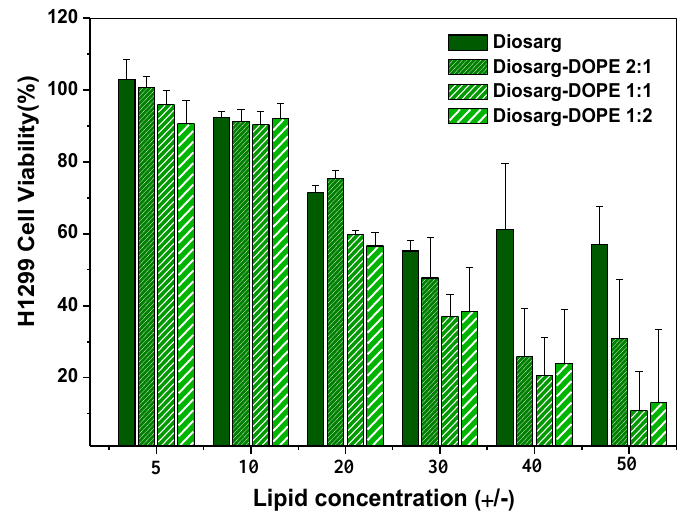
Figure 4. Cytotoxicity of H1299 cells incubated with the Diosarg lipid and Diosarg-DOPE NPs at various +/− charge ratios (pDNA 0.5 μg/well), with the Diosarg lipid at the same +/− charge ratio as the control.